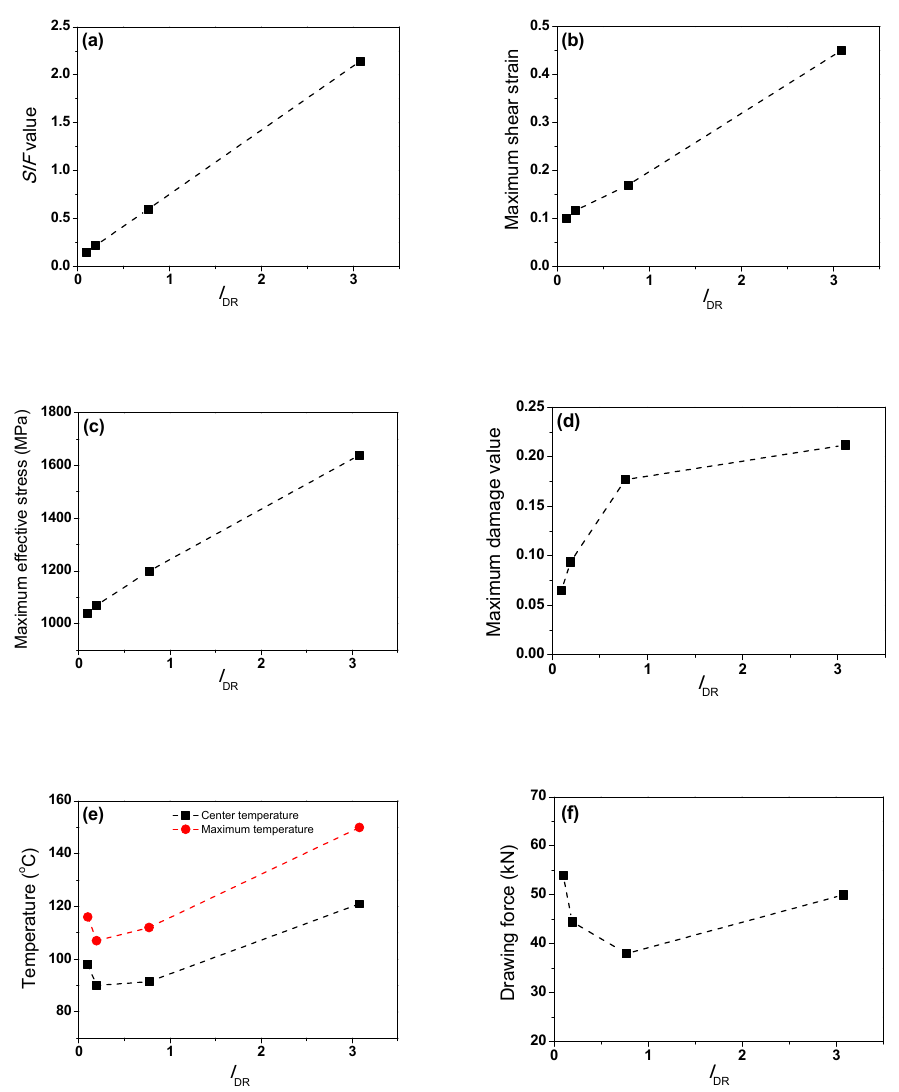
Figure 12. Variations in ( a ) SIF value, ( b ) maximum shear strain, ( c ) maximum effective stress, ( d )